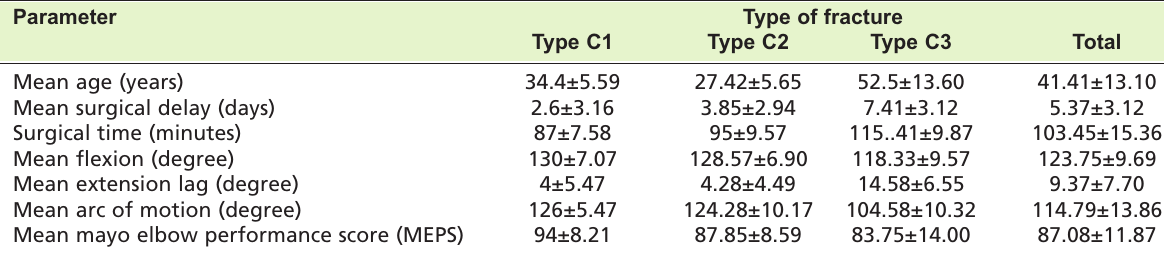
Demographic data and functional outcome for olecranon osteotomy Table I: